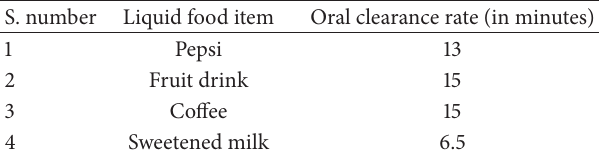
Table 3: Oral clearance rate of different liquid food items. S.